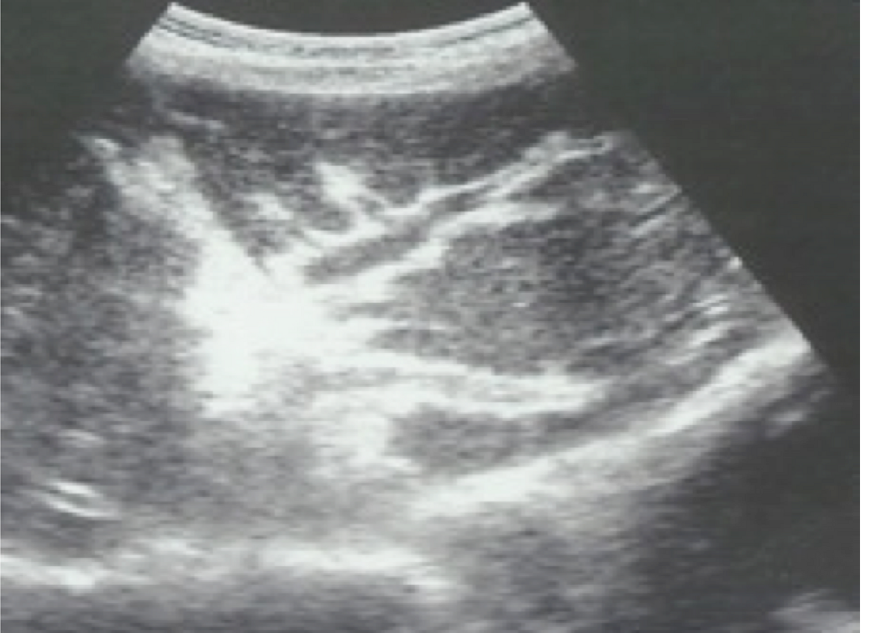
Figure 1. Ultrasound image of periportal fibrosis in S.mansoni infection. The image was taken during ultrasound examination of a study cohort from Piida village on the shores of Lake Albert, Uganda, in March 2004 and illustrates liver texture pattern C with ‘‘pipe-stems.’’